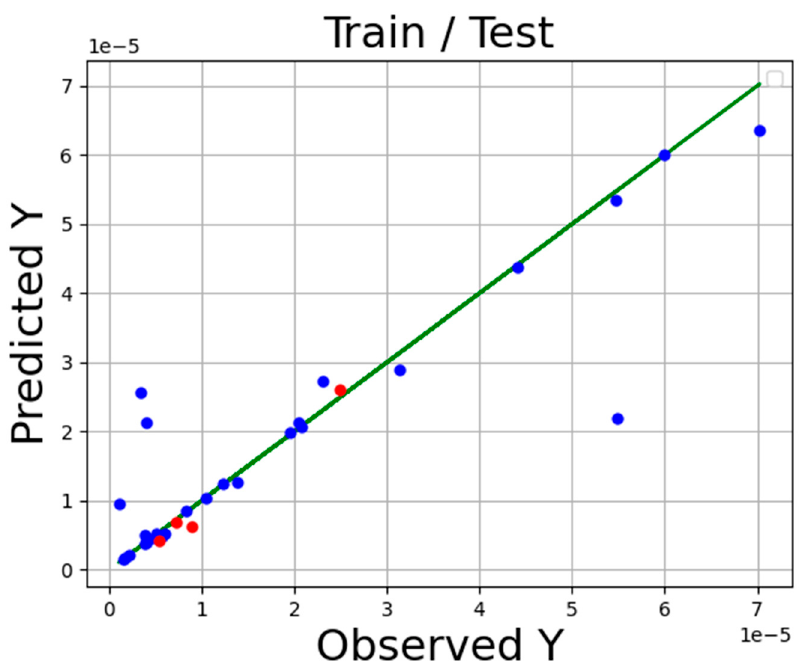
Figure 2. Fitting chart for ADA ‐ GPR.